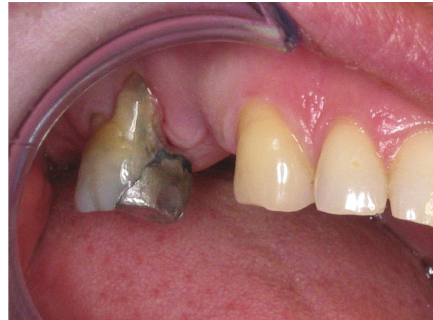
Figure 3: Extraction site immediately after tooth removal.